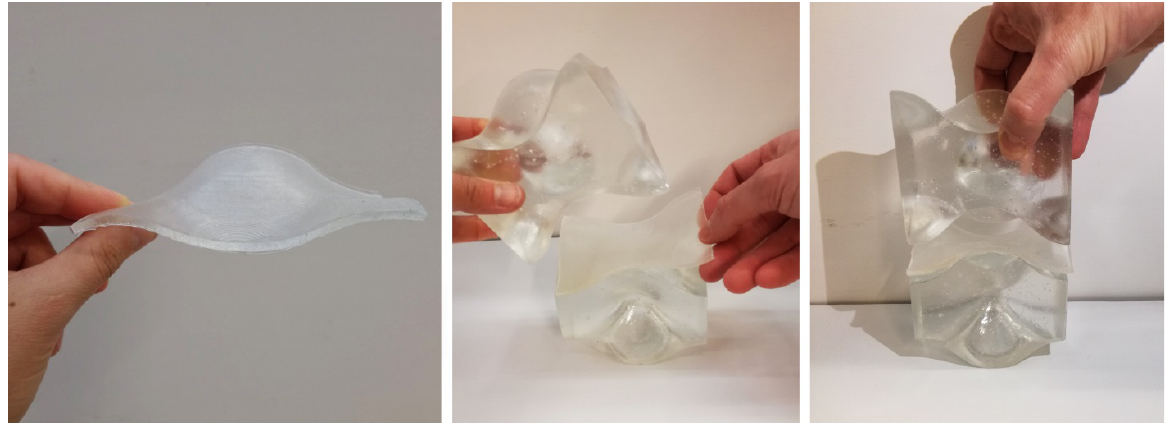
Fig. 10: Prototype of a 3 mm thick, cast interlayer made out of PU70 for the type A blocks.